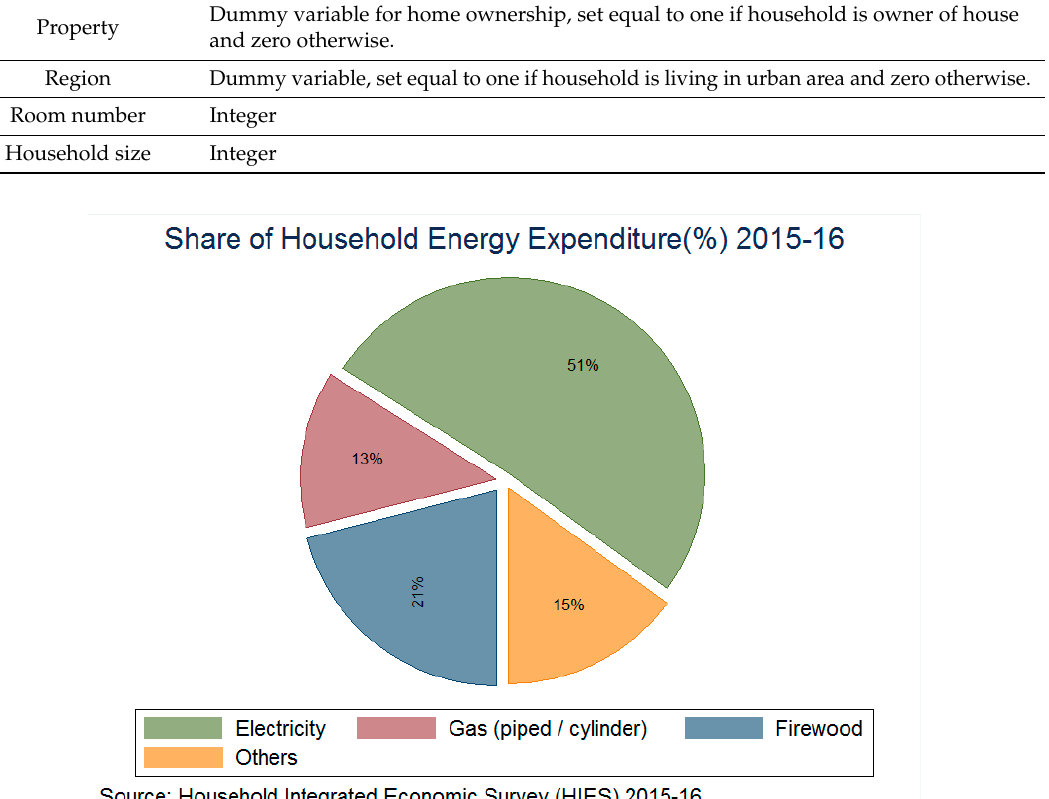
Figure 5. Share of Household Energy Expenditure (%) 2015–2016.